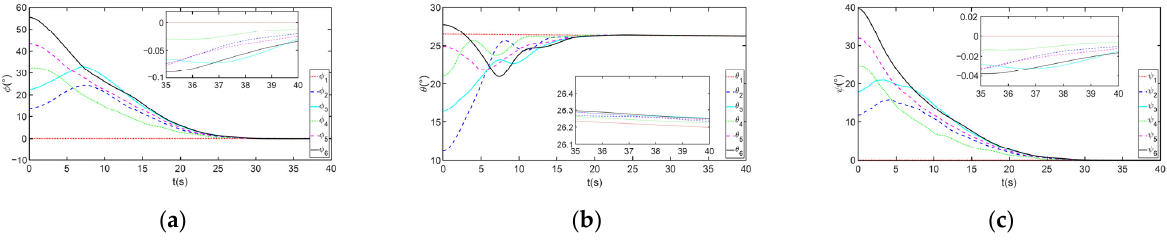
Figure 4. The attitude of the swarm utilizing LP systems: ( a ) Roll attitude; ( b ) Pitch attitude; ( c ) Yaw attitude.